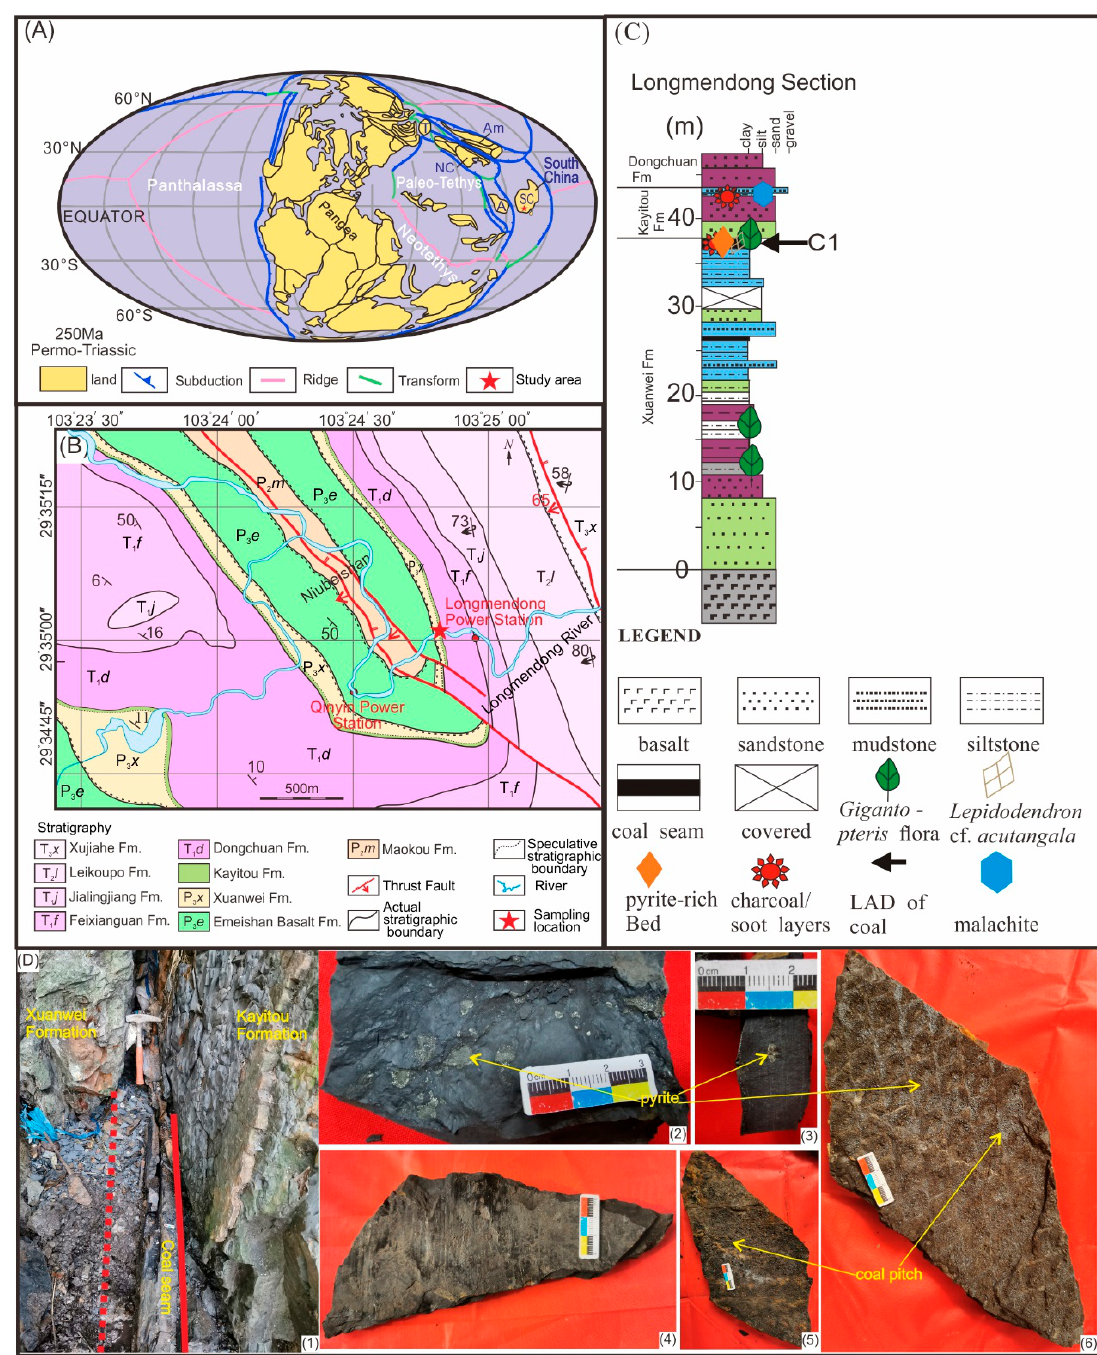
Figure 1. ( A ) Global paleogeographic plate reconstruction at ~250 Ma (Permo-Triassic boundary) (modified from [52]). Abbreviated continental units: A, Annamia; Am, Amuria; NC, North China; SC, South China; ( B ) Simplified geological map of the Longmendong area (modified from [53]); ( C ) Stratigraphic section and sampling location of the Longmendong section (modified from [46]). The lithology coloring approximately represents that of the rocks according to the Munsell color system; ( D ) Outcrop and macroscopic photographs of the last coal seam in the Longmendong section, the detailed description of the figures can be seen in Part 3.